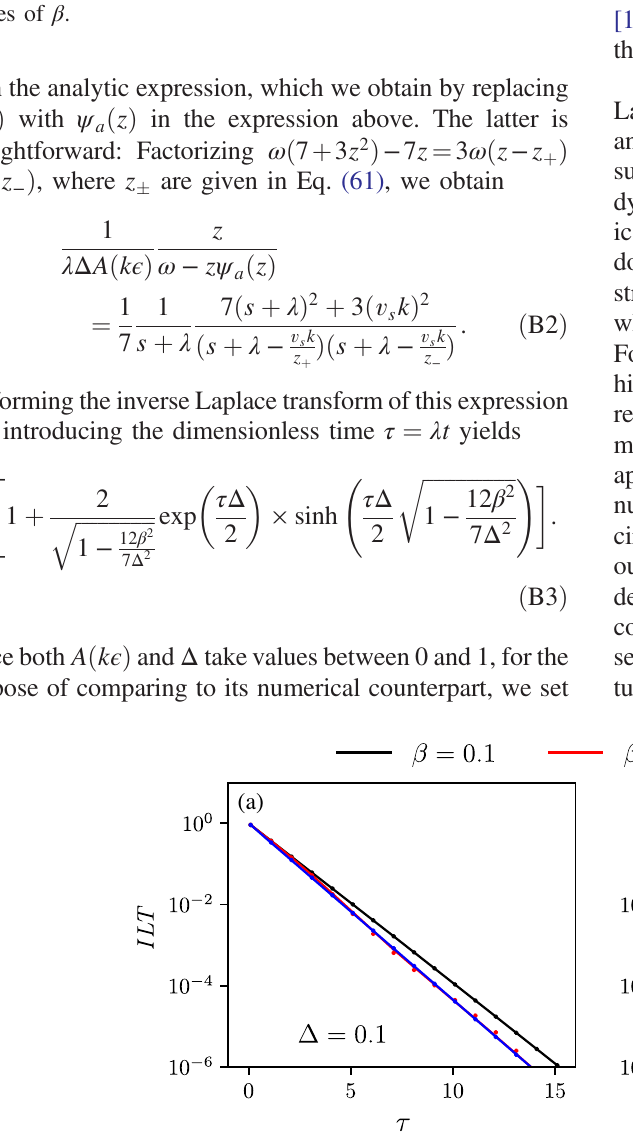
FIG. 8. Numerical inverse Laplace transform (ILT) of Eq. (B4) (circles) and the analytical approximation [Eq. (B3)] (solid lines) as functions of time. (a) Δ ¼ 0 . 1 . (b) Δ ¼ 0 . 9 . Inset: The same data on the linear-linear